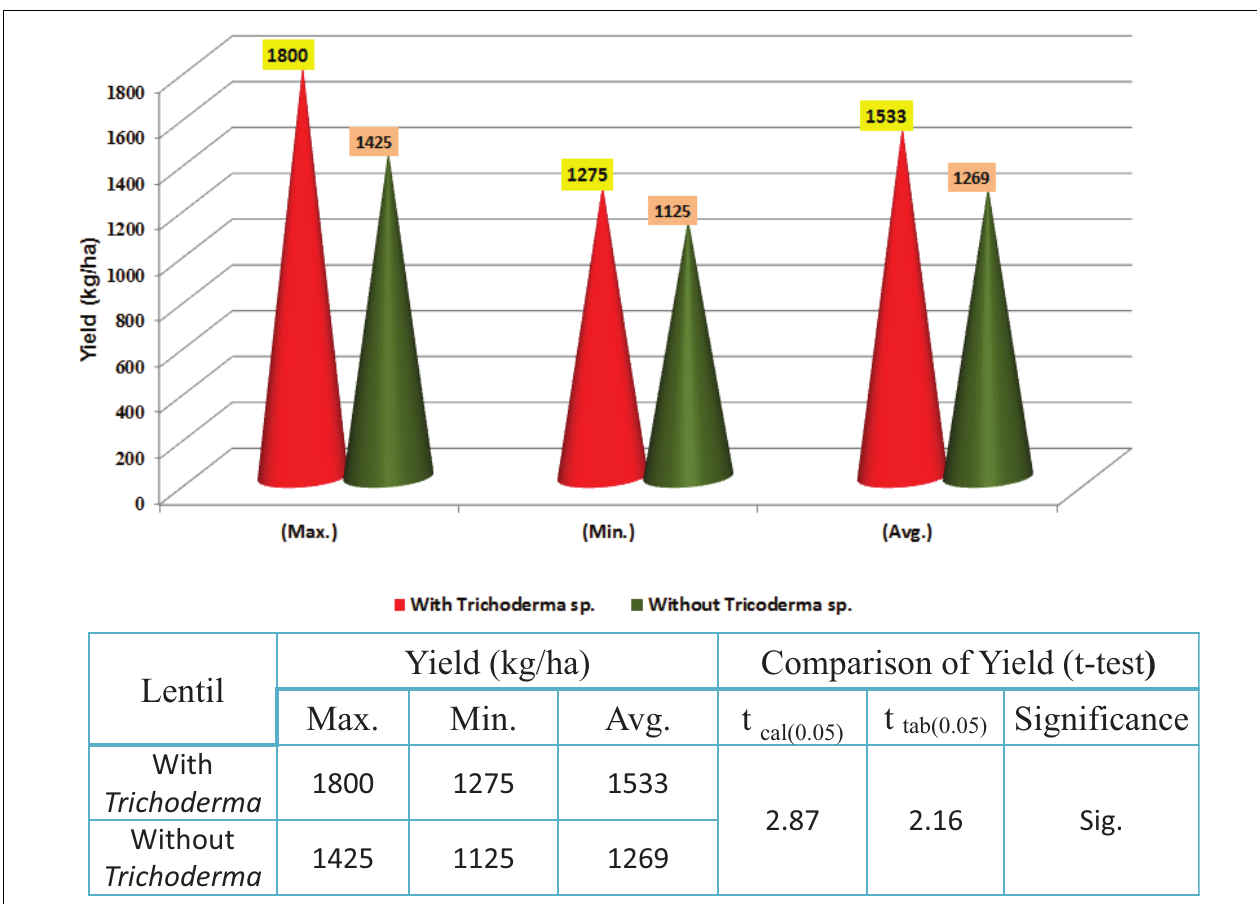
FIGURE 13 | Yield data of farmers’ field trials taken at 30 farmers’ fields in Nadia district of West Bengal (2017–2018).